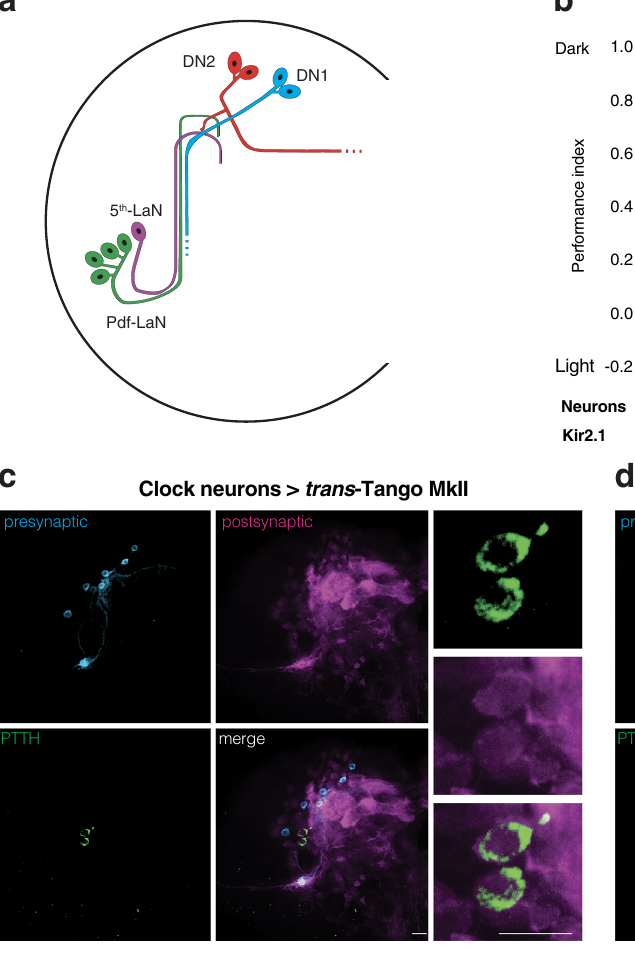
Fig. 1 | Input from Pdf-negative clock neurons into PTTH neurons mediates lightavoidance.a Schematicofclockneuronsinthe Drosophila larvalbrain. b The effectofKir2.1-mediatedneuronalsilencingonlightavoidanceat550lux.Silencing ofallclockneuronsorPTTHneuronsdecreasesphotophobia,silencingofPdf-LaNs has no effect. Boxplots indicate median (middle line), 25th and 75th percentile (box),barsrepresentmaximumandminimum.One-wayANOVA,ns:notsigni fi cant,